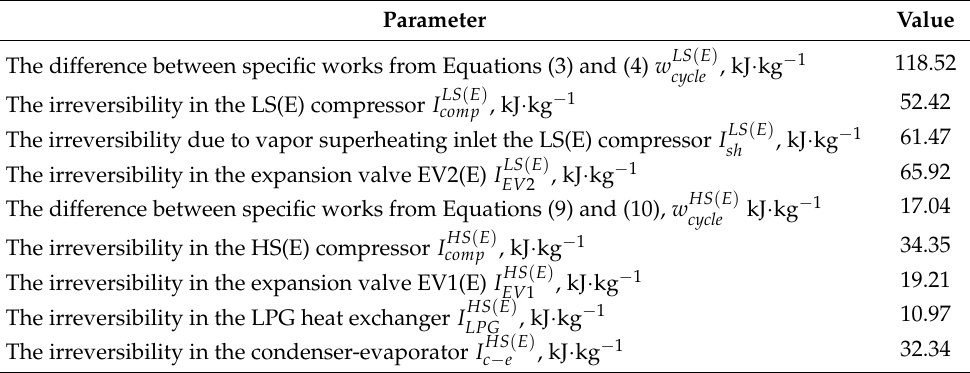
Table 3. The analysis of the bottoming stage of the cascade system.